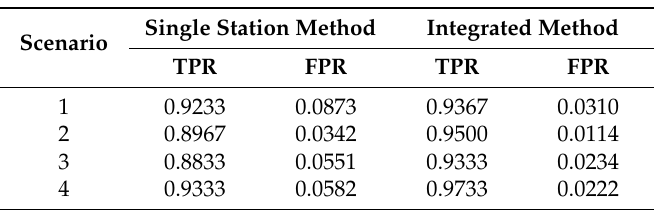
Figure 4. Performance comparison between the single station method based on the threshold model and the fusion method combining temporal and spatial information (time sequence). The first sub-figure shows the test data and events (marked with squares). The second sub-figure shows the detection result of single station method based on the threshold model. The third sub-figure shows the detection result of the fusion method using both temporal information and spatial information. Table 1. Performance comparison between the single station method based on the threshold model and the fusion method combining temporal and spatial information (TPR, FPR).